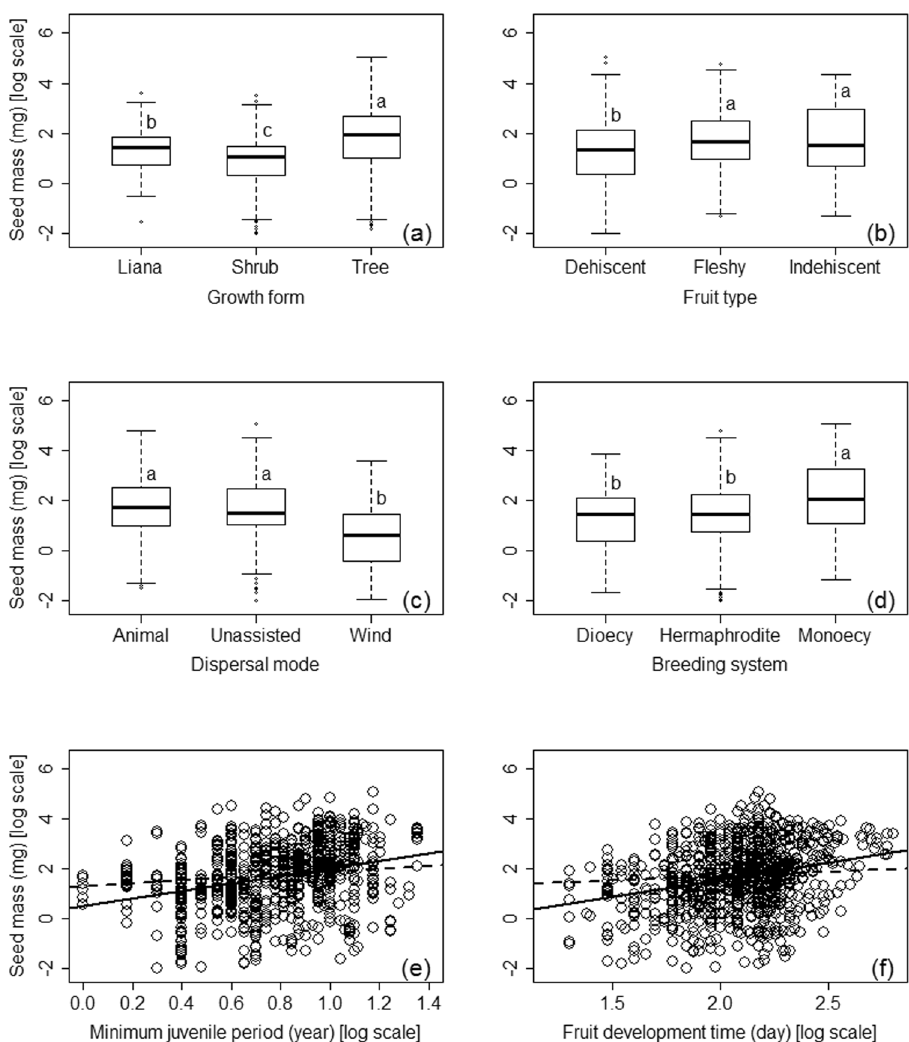
Figure 2. Associations between seed mass and ( a ) growth form, ( b ) fruit type, ( c ) dispersal mode, ( d ) breeding system, ( e ) fruit developing days and ( f ) minimum juvenile period in Chinese woody angiosperms. In ( a ) to ( d ), means with different letters were significantly different at P < 0.05. In ( e , f ), Solid line represent result of linear regression, while dashed line represent that of phylogenetic model. The analyses are conducted with all species available for each trait, with n = 1265 in ( a ) to ( d ), n = 935, 880 in ( e , f ) respectively.